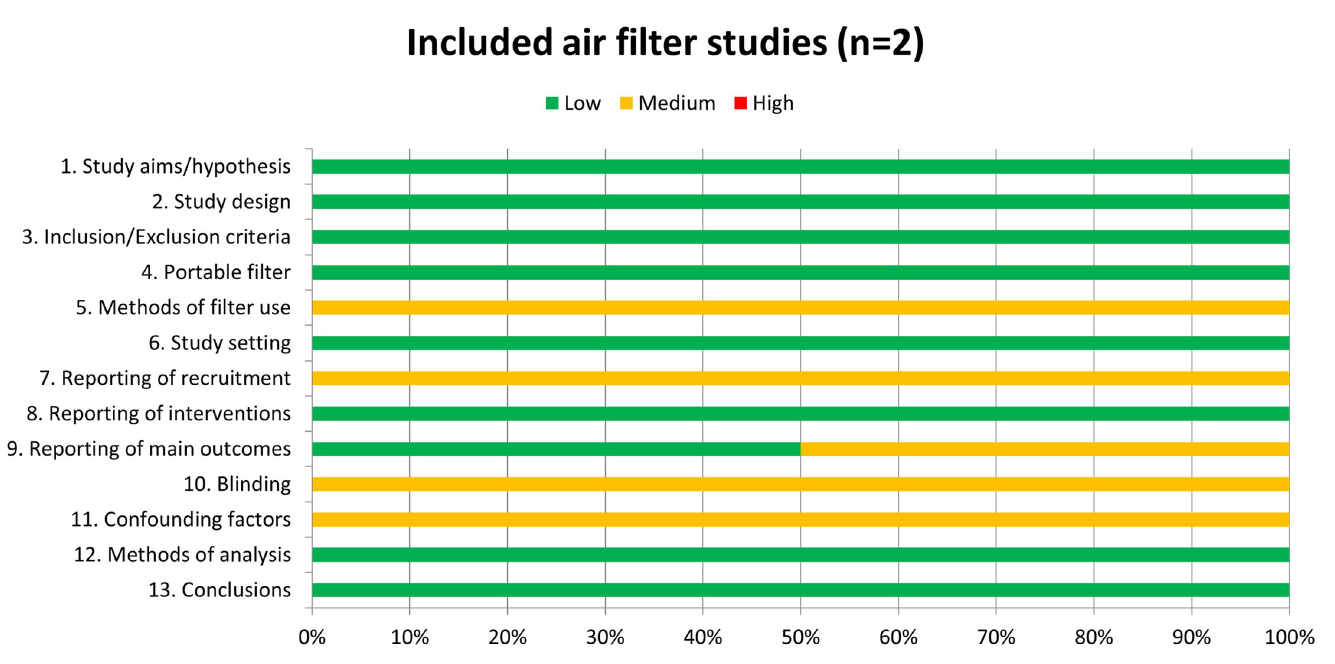
PLOS ONE | https://doi.org/10.1371/journal.pone.0251049 April 29,